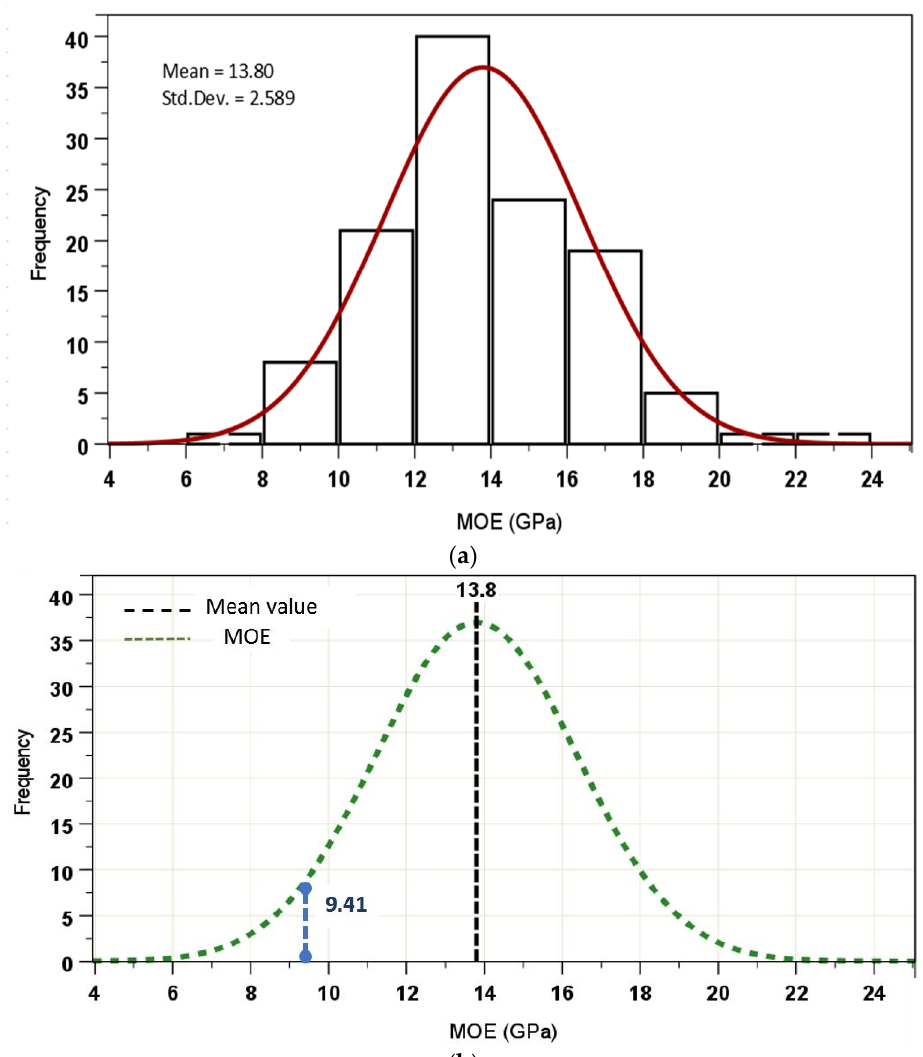
Figure 9. Statistical distribution of boards population ( a ) Normal distribution of the MOE of the E. nitens timber boards ( b )